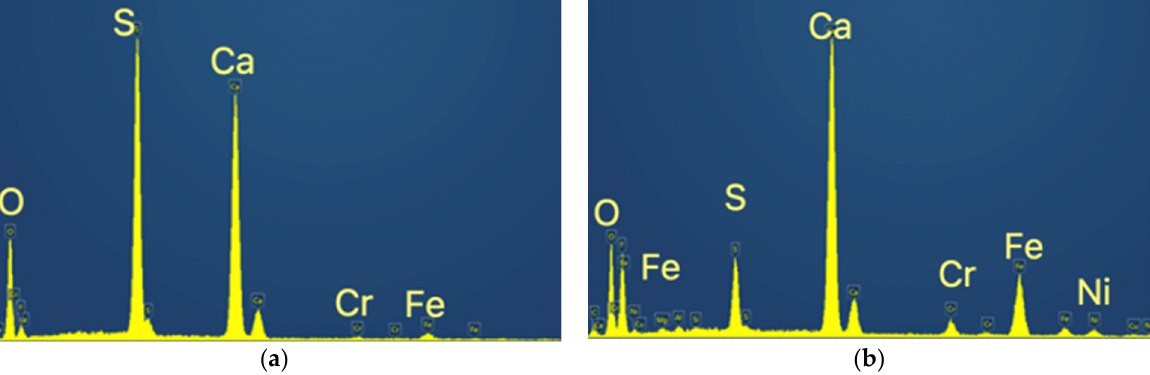
Figure 6. EDS spectra for the tubular-like crystals and for the round-shaped grains. ( a ) Spectrum of Z1 (tubular crystals); ( b ) Spectrum of Z2 (round shaped grains).